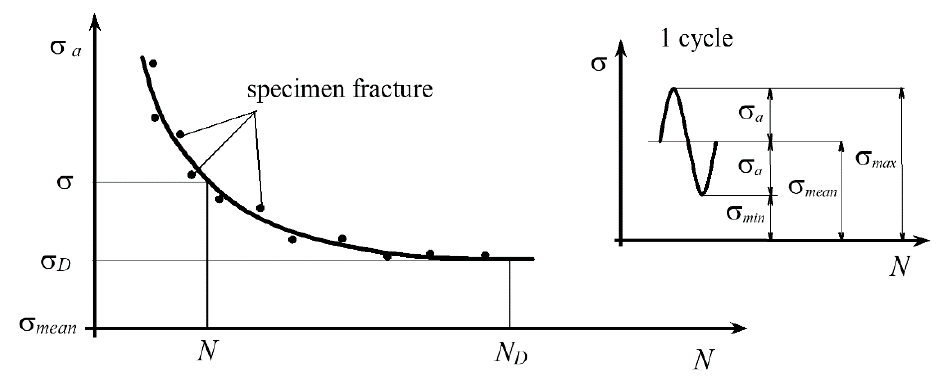
Figure 1. Dynamic strength curve for a given σ mean .